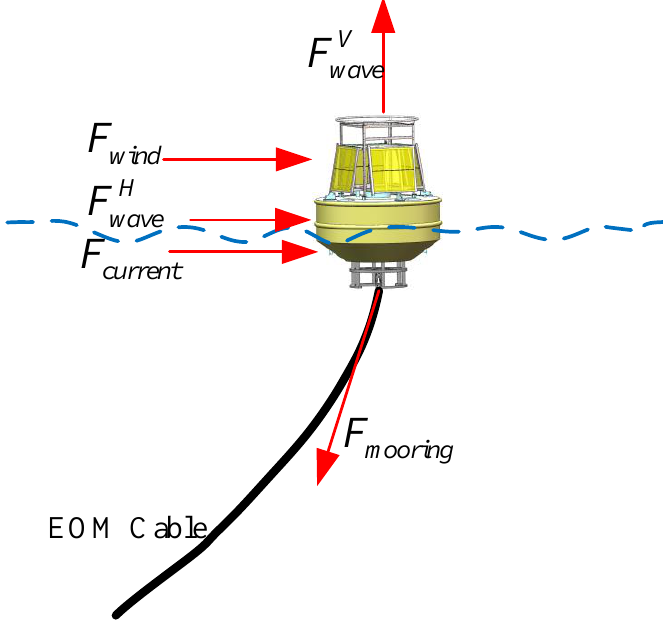
Figure 7. External loads on buoys other than buoyancy and gravity.